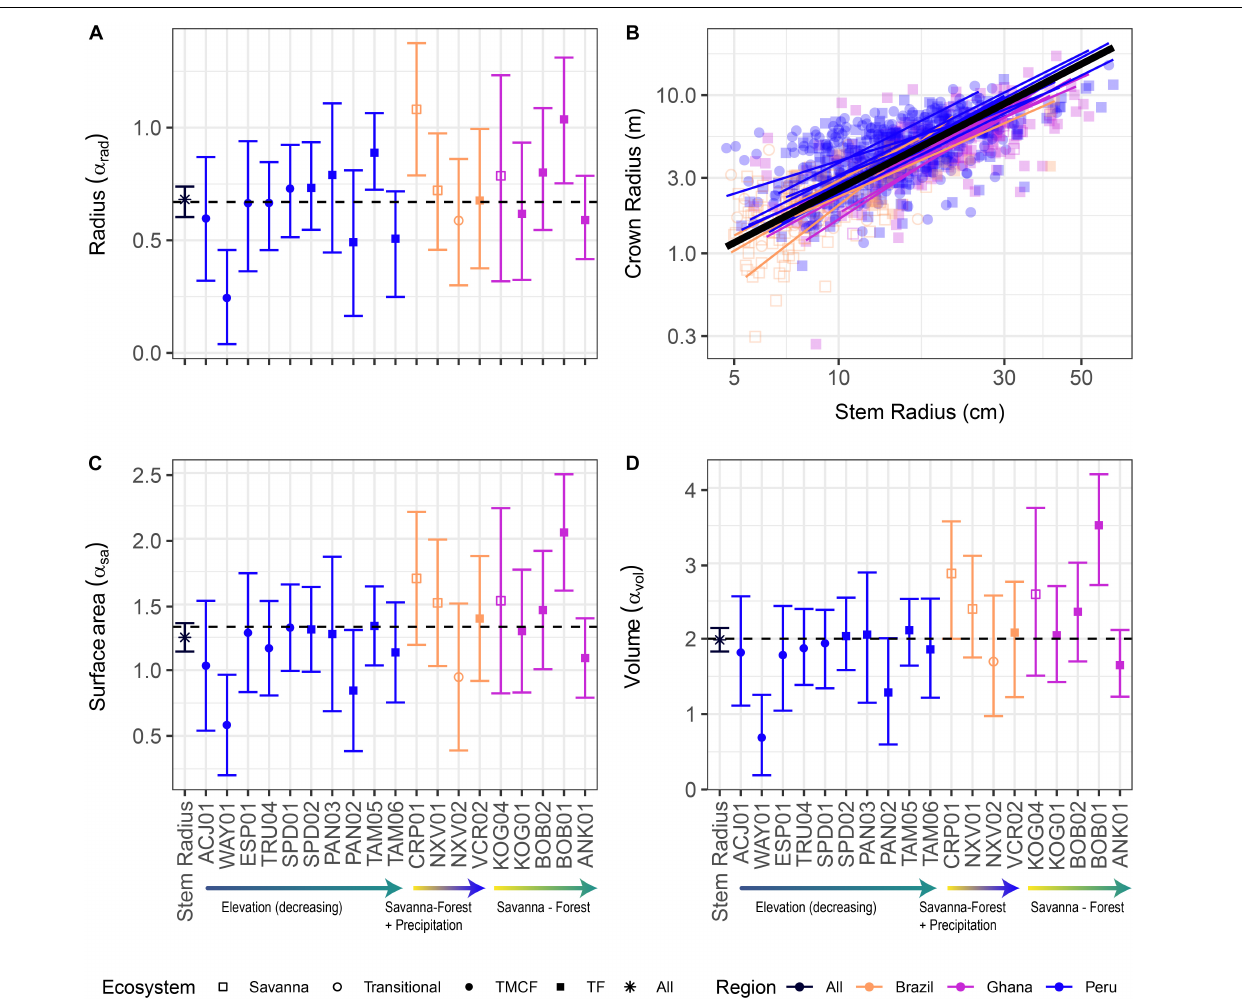
FIGURE 2 | Crown vs. stem radius LMM scaling exponents for crown radius (A) , surface area (C) , and volume (D) . Data and SMA fits shown in (B) for crown radius scaling (surface area and volume fits are similar, and can be found in Supplementary Material ). “Stem Radius” equates to α dim in Eq. 3. Black dotted lines indicate α predicted by Metabolic Scaling Theory. Site × stem radius interactions are indicated by the site labels below, and per-site intercepts are not shown (see Supplementary Figures S9, S15, S20 . for β terms and Supplementary Figures S14, S19 . for SMA fits vs. data). Model includes random intercepts and slopes per species. Error bars indicate 95% confidence intervals fit by likelihood surface profiling. Categorical site variables were encoded as deviation contrasts, which fits the magnitude of the site coefficients as the mean of the slope at that site minus the grand mean slope across all individuals. In order to aid interpretation, we added the grand mean to each site effect and its confidence interval. The Stem Radius effect represents the main effect of stem radius on crown radius, and in this context is the grand mean across all individuals, taking the species random effects into